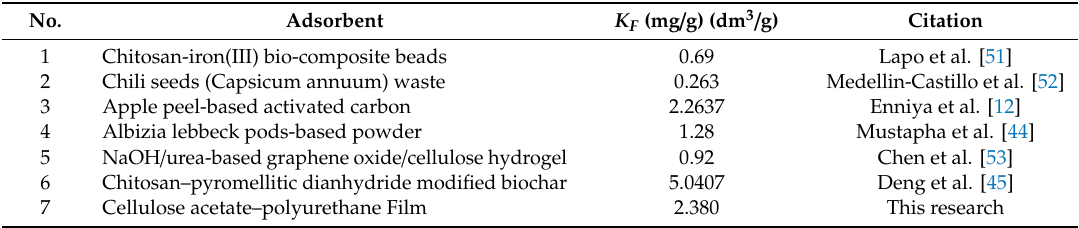
Table 5. Comparison of K F with previous